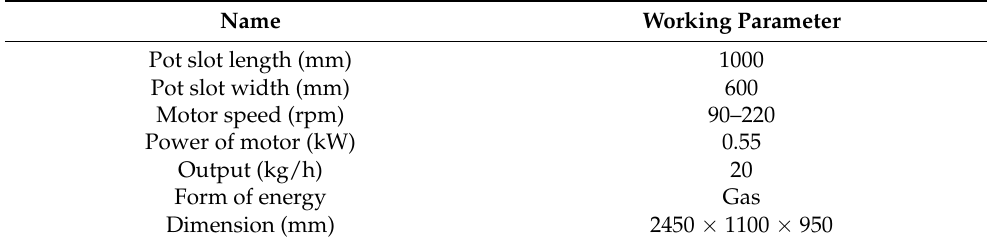
Table 1. Main working parameters of tea carding machine.